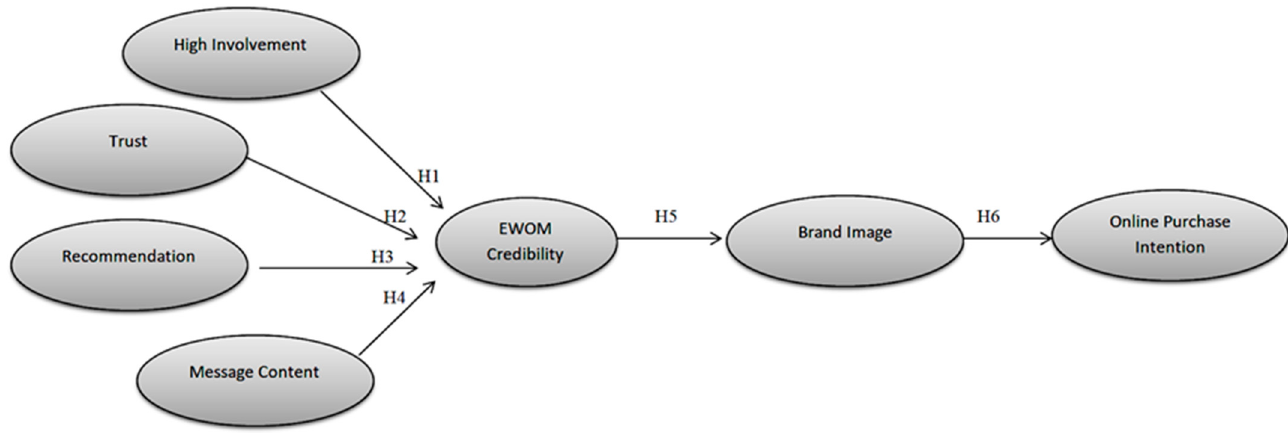
Figure 1. Conceptual structure of the study.